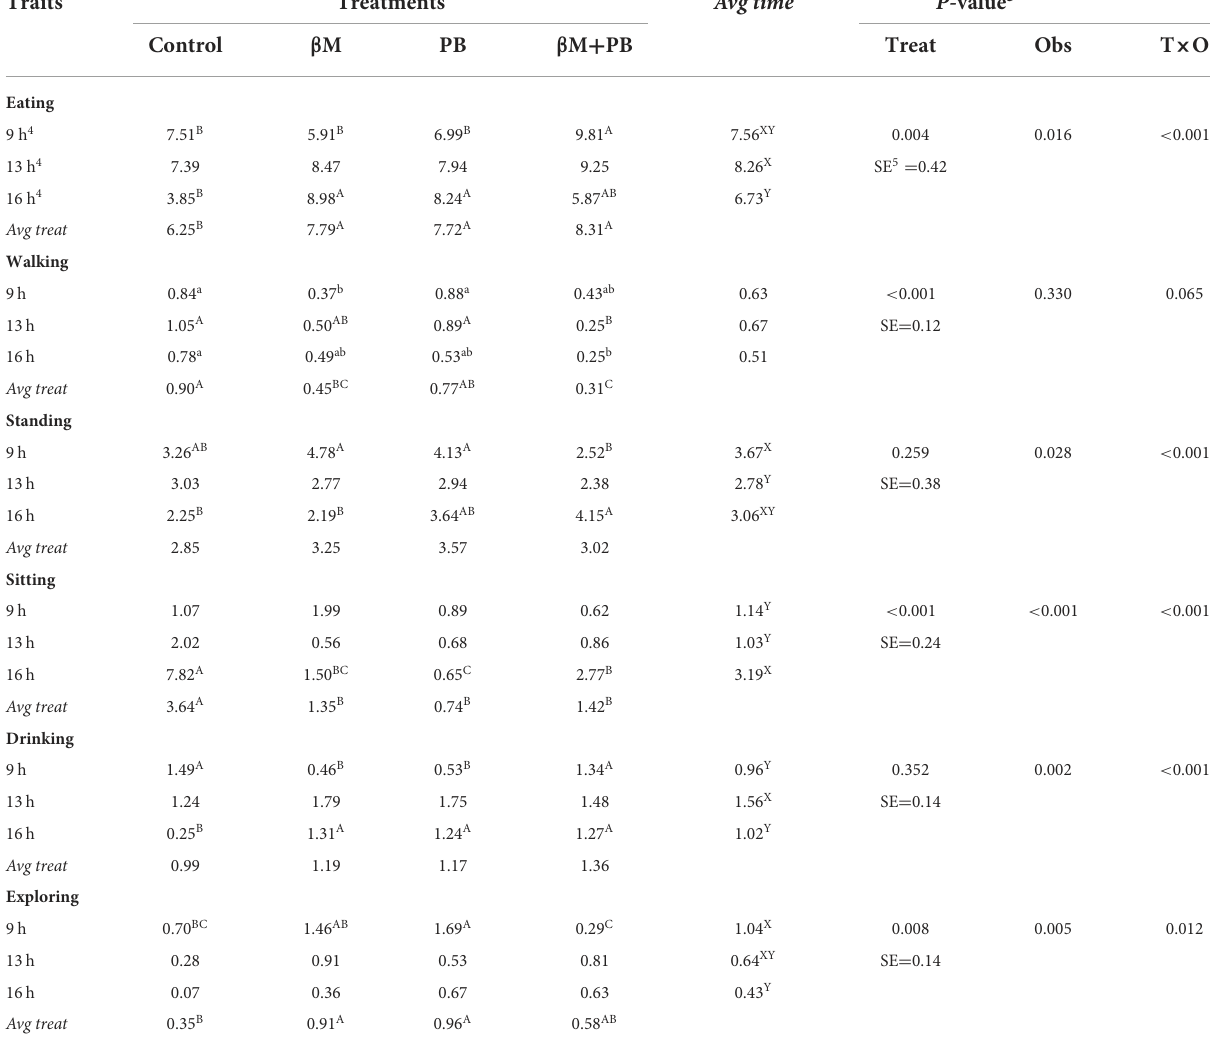
TABLE 3 Time expended (minutes/bird) 1 in each of the main behaviors by laying hens fed β -mannanase and/or probiotics 2 .